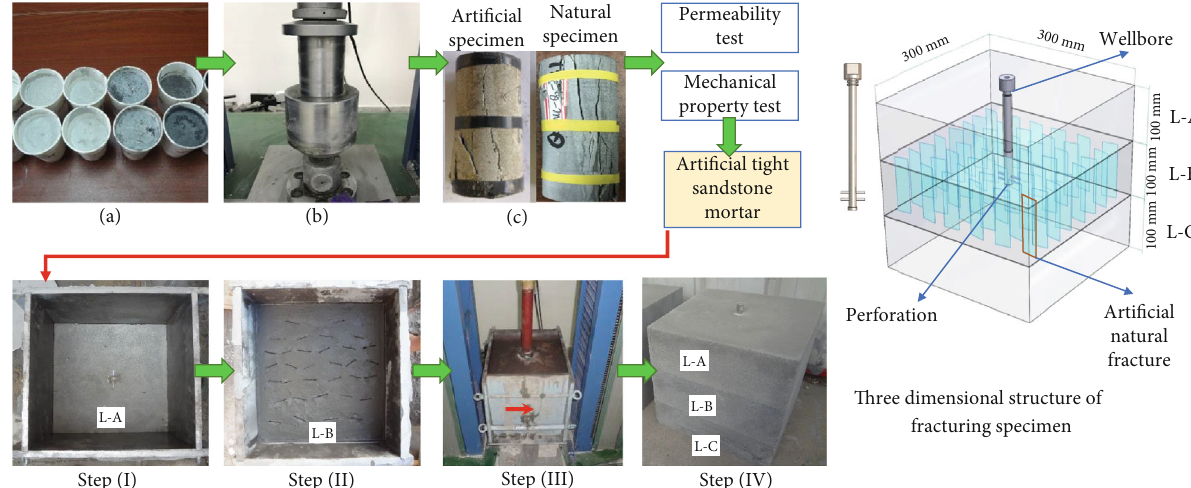
Figure 1: Preparation procedure of arti fi cial tight sandstone specimens with multiple